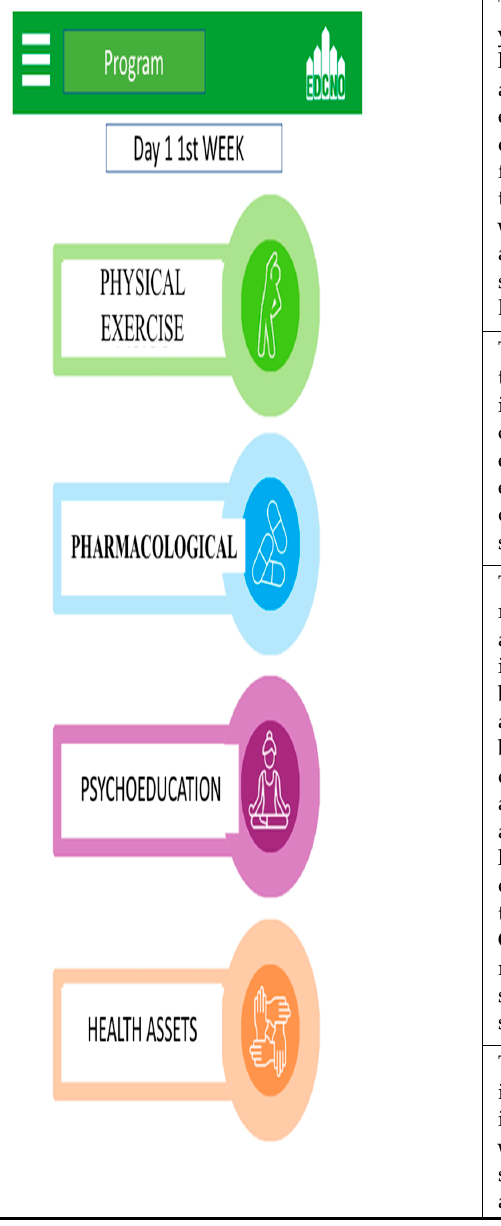
Table 7. Multimodal intervention: physical exercise, pharmacological treatment, Psychoeducation, health assets.